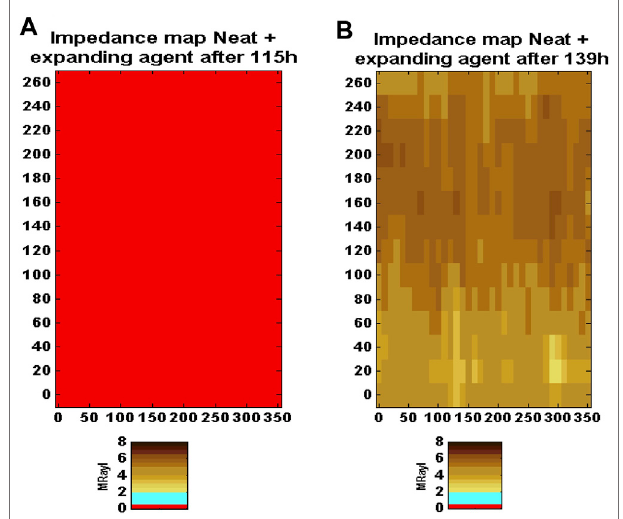
FIGURE 6 | Acoustic impedance maps for the expansive cement formulation after reducing the casing pressure. (A) is the impedance map before the heat treatment (after 115 h curing at 30 ° C). The impedance values are close to zero everywhere, indicating the presence of a complete dry microannulus. (B) is the impedance map after 8 h heat treatment at 66 ° C and 8 h normal curing at 30 ° C (after 115 h curing at 30 ° C). Acoustic coupling has been restored, indicating that the microannulus has closed. After (Thomas J. et al., 2014).